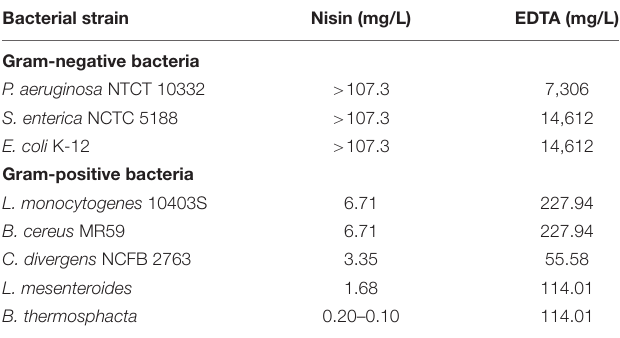
TABLE 1 | MICs obtained for nisin and EDTA against the bacterial strains studied. Bacterial strain Nisin (mg/L) EDTA